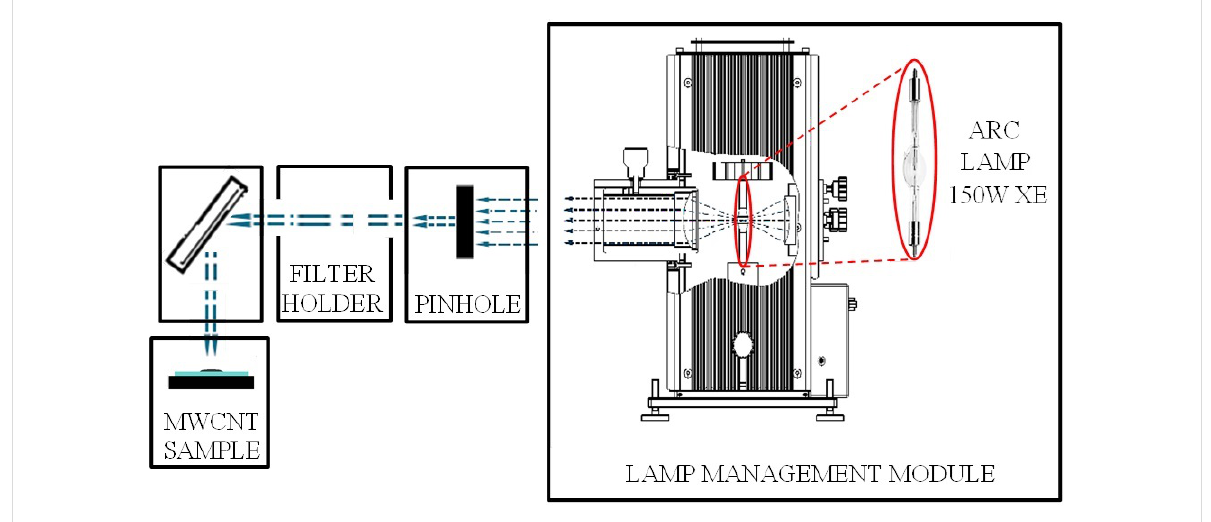
Figure 7: Schematic of the experimental setup for photo-ignition tests of the MWCNT/ferrocene mixture using a CW Xe lamp.